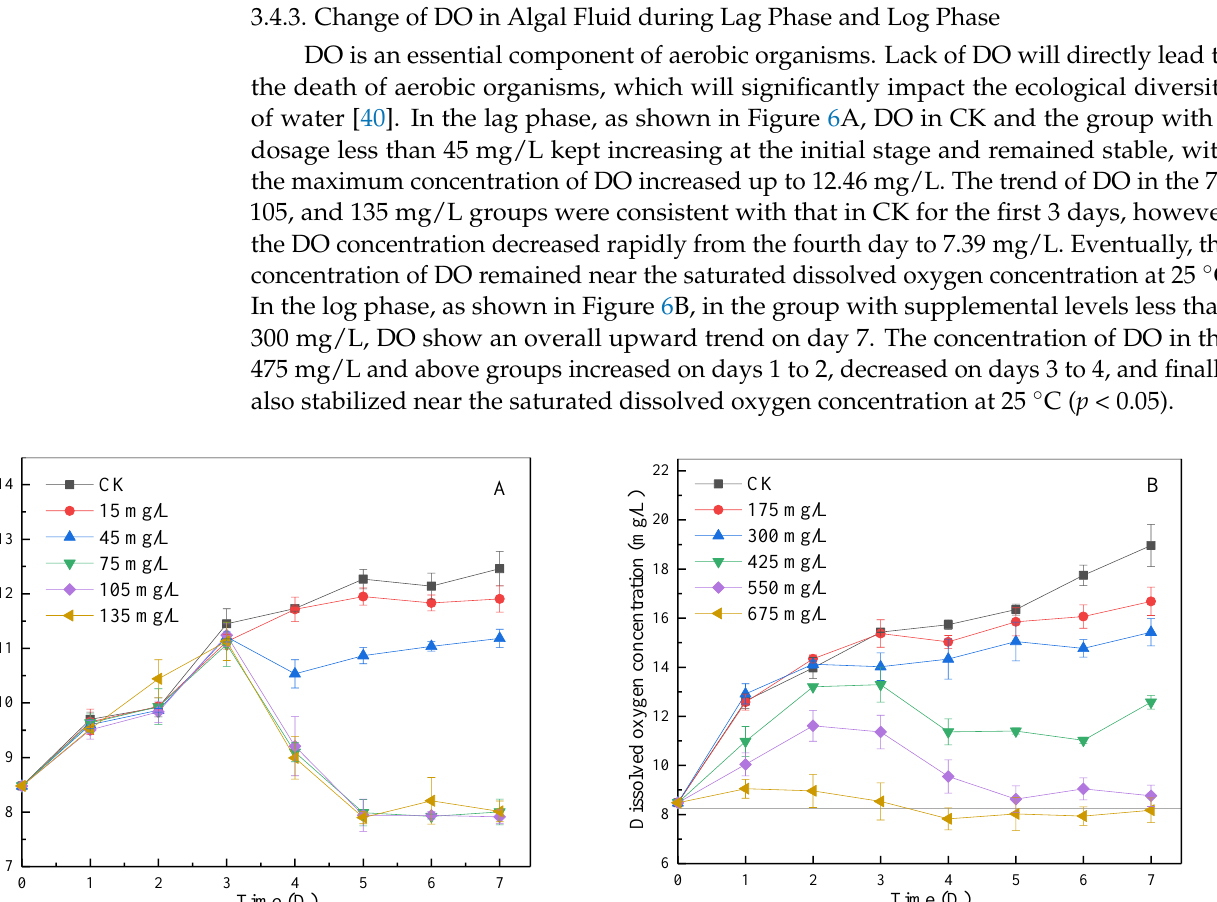
Figure 5. The effect of SA-CS on the concentration of pH in algal liquid at lag phase and log phase: ( A ) the effect of SA-CS on pH at lag phase; ( B ) the effect of SA-CS on pH at log phase.